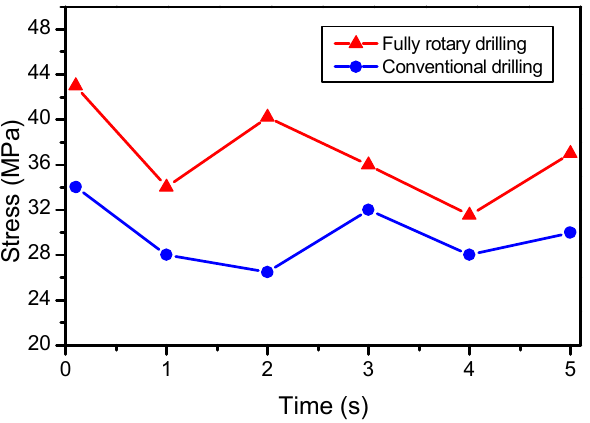
Figure 9. Maximum equivalent stress versus time for both conventional and fully rotary drilling.